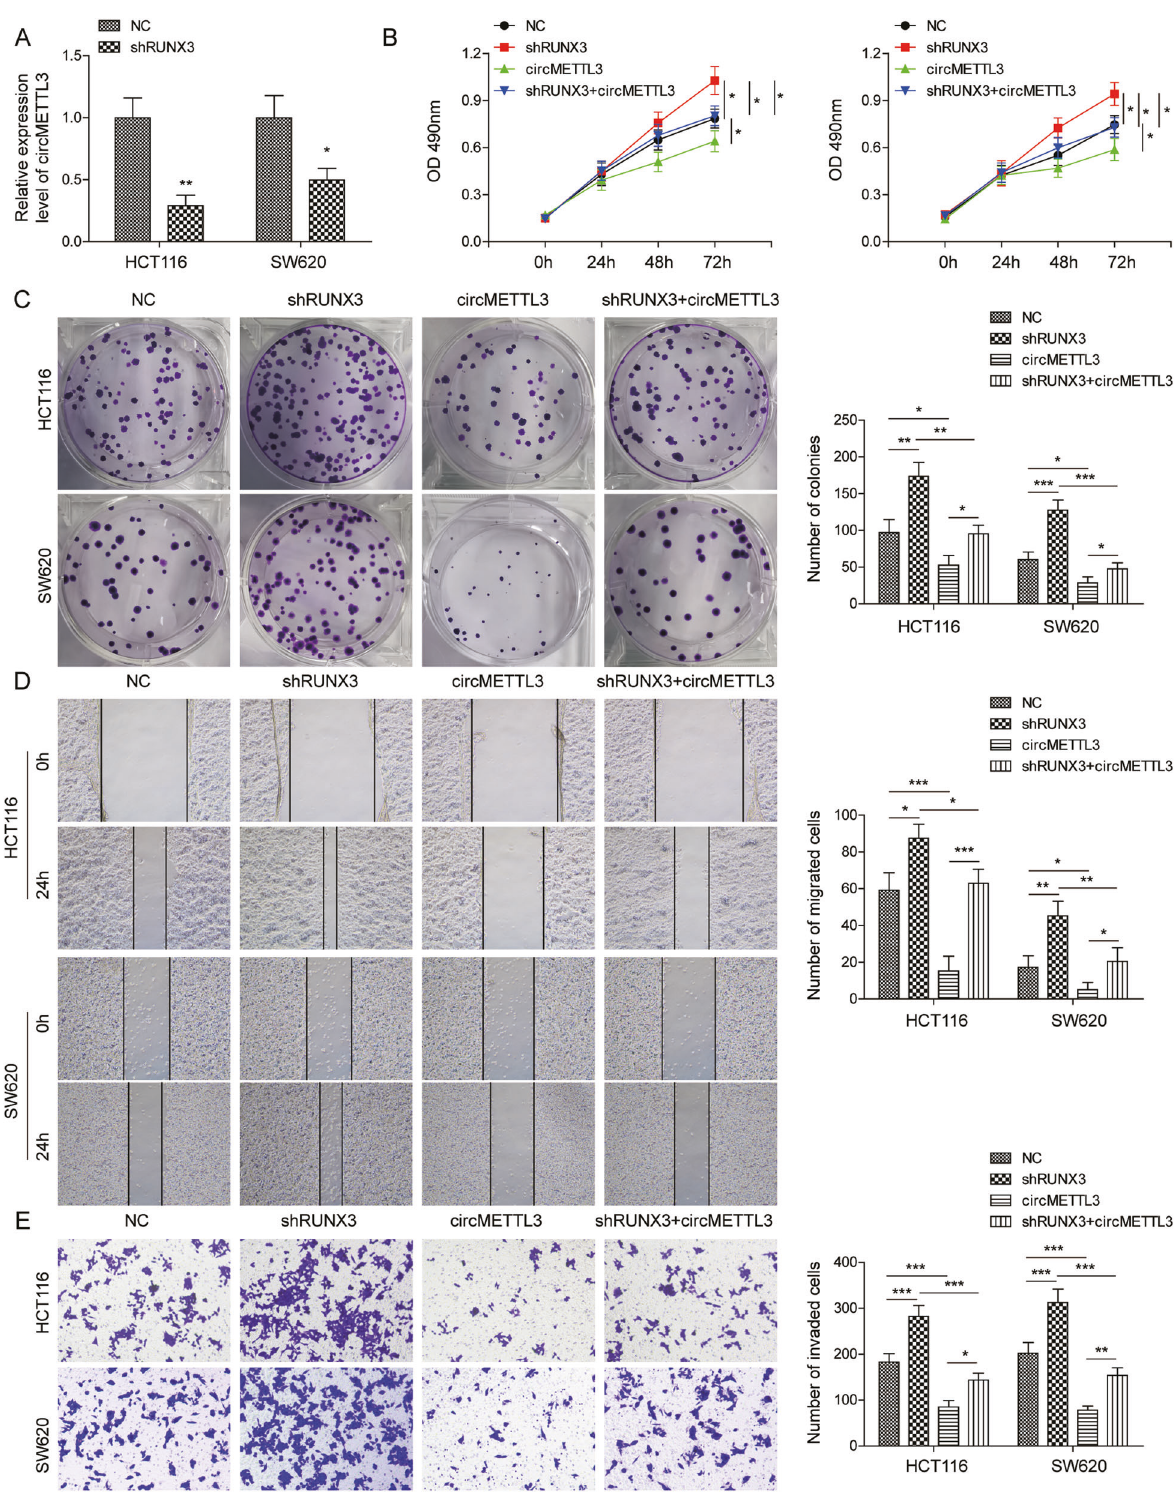
Fig. 4 RUNX3 regulated CRC cell prolfeiration and migration via circ-METTL3. A Relative circMETTL3 levels in transfected HCT116 and SW620 cells. B CCK-8 assay to measure cell viability. C Colony formation assay to assess cell proliferation. D Scratch wound assay to analyze cell migration ability. E Transwell assay to evaluate cell invasion been revealed. One study indicates that RUNX3 suppresses cancer cell proliferation and invasion [26]. In oral squamous cell metastasis and stemness of CRC by inhibiting Hedgehog signaling carcinoma, RUNX3 restrains cancer cell migration and tumor [28]. Another work suggests that RUNX3 inhibits angiogenesis growth [27]. In CRC, many studies have reported similar [15]. Moreover, RUNX3 has been shown to promote TRAIL-induced suppressive role of RUNX3 [15, 28]. Several mechanisms have